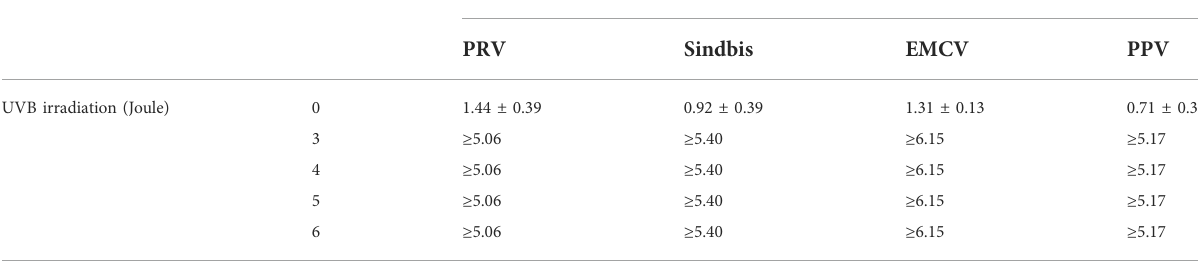
Data represent mean ± SD, and n = 3 biological repeats.